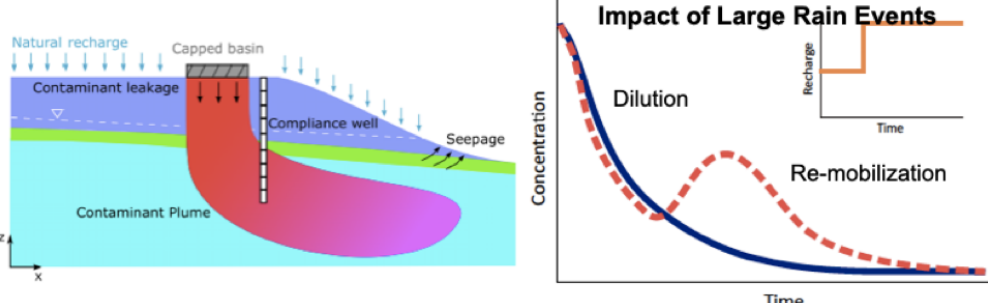
Figure 2. Left: illustration of the hydrological conceptual model under investigation, representing a vertical 2D cross section driven along the middle line of the contaminant source zone. Right: schematic diagram of the impact of increased recharge on the concentration breakthrough curve (BTC) at an observation well located downgradient from the source zone. Modified from Libera et al. (2019).